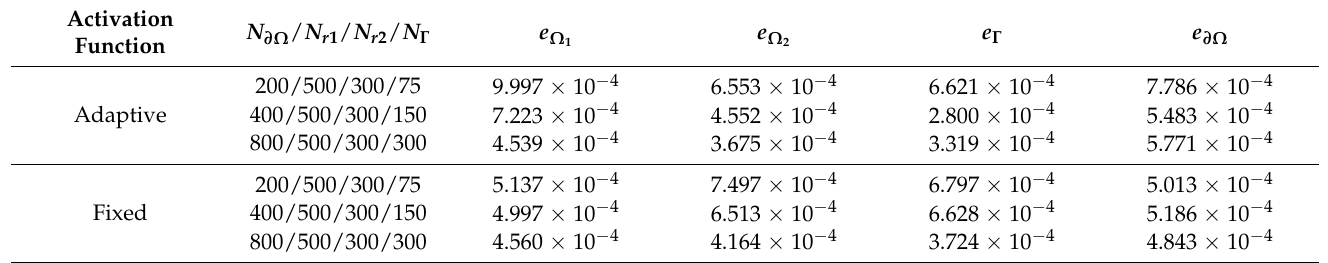
Table 1. Comparison of the errors of the adaptive and the fixed activating function strategies for different numbers of training points for Example 1.